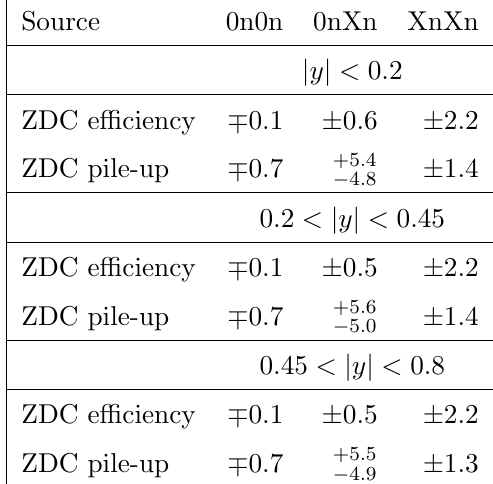
Table 3 . Summary of the systematic uncertainties related to the forward-neutron class selection. The percentile variation of the cross sections is shown. See text for